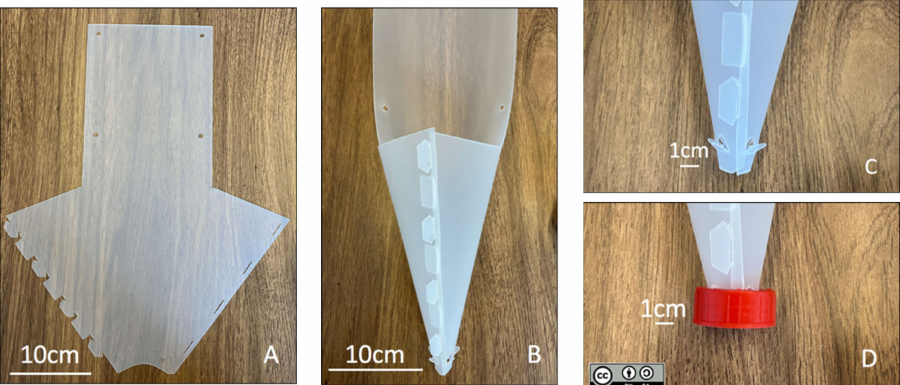
Figure 1. An unfolded and an assembled fan-trap . Details of the collecting-container cap attach- ment. ( A )—The flat design; ( B )—folded trap; ( C )—pre-cut wedges used for attaching the collecting container’s cap; ( D )—cap attached to the bottom of the trap.